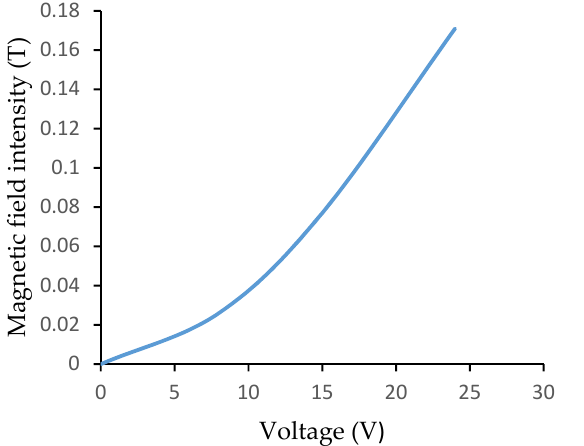
Figure 4. Excitation curve of electromagnet (Measurement of magnetic field intensity).